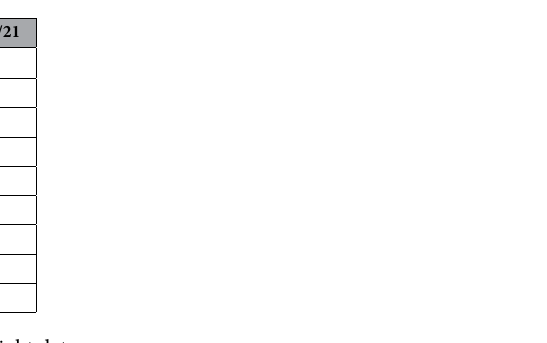
Figure 6. Map of flight area around the University of Western Australia campus in Perth, Western Australia. Red dot is the deployable optical terminal on the roof of the physics building, blue lines are static link paths, red line is the drone flight path during the 2022/04/21 flight. Map generated with OpenStreetMap data under the Open Database License (openstreetmap.org/copyright).